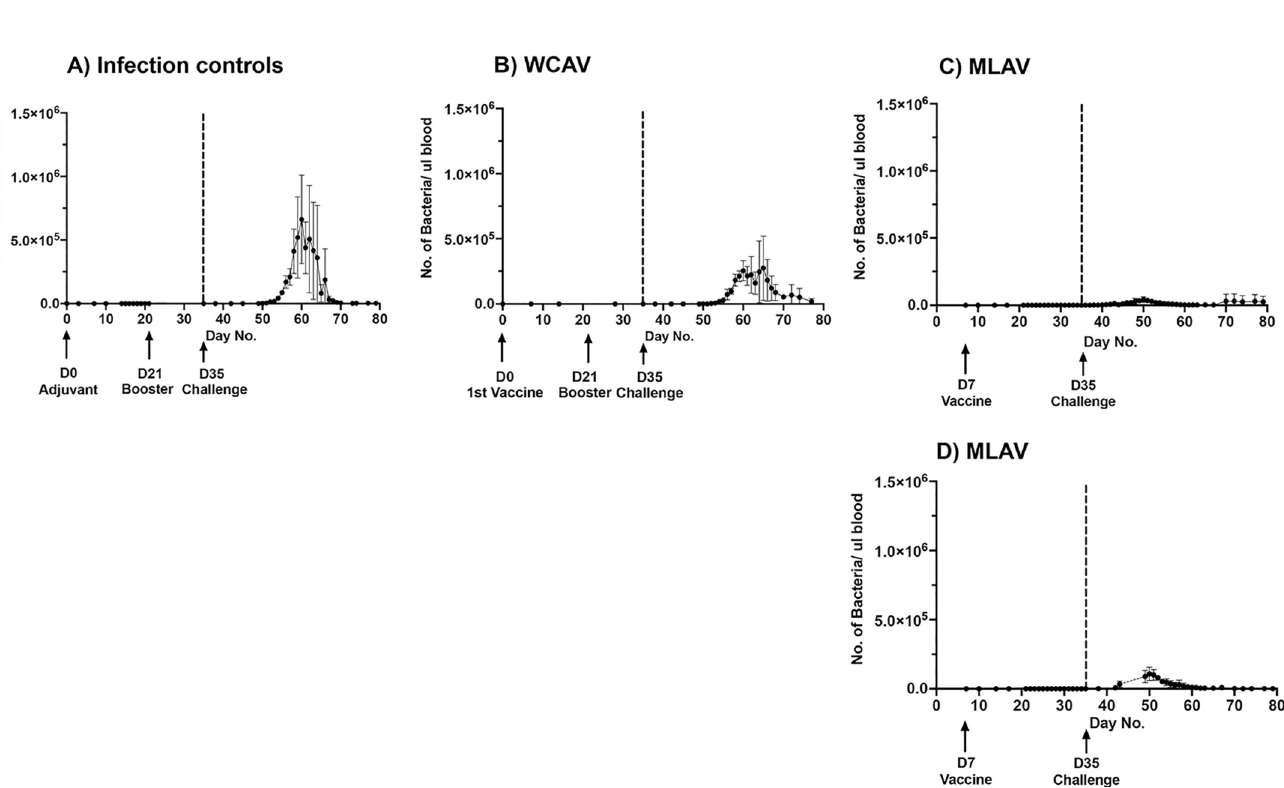
Fig 6. Bacterial numbers in blood assessed by real-time qPCR. The 16S rDNA TaqMan probe-based qPCR assays were performed for samples collected from all three groups animals over the study period (A-C). The MLAV group animal samples were also assessed by mCherry qPCR assay (D). Significance for days 55–65; at significance level α = 0.05, one-way ANOVA with repeated measures showed that 16S rDNA copy numbers of wild-type A . marginale bacteria were significantly different between the infection control, WCAV and MLAV groups (P = 0.0375 � ), for several days post-challenge. Additionally, Tukey’s multiple comparisons test showed a significant difference between infection control and MLAV groups (P = 0.0294 � ). No significant difference was observed between infection control and WCAV, or WCAV and MLAV.